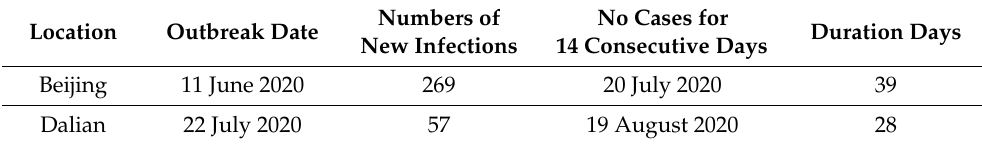
Table 4. Epidemic situation in Beijing and